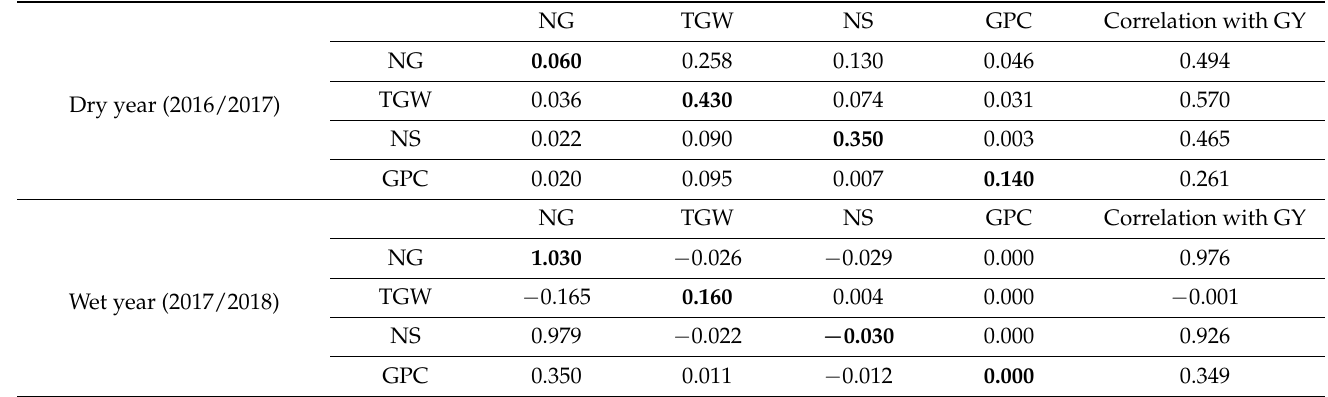
Figure 4. Relation between grain protein content (GPC %) and nitrogen agro-physiological efficiency (APE) in a dry year (2017); left [R 2 = 0.47 **, p -value < 0.01], and in a wet year (2018) right [R 2 = 0.16 ns ]. (ns: no significant, **: p < 0.01). Table 5. Path coefficient of the direct and indirect effects of the number of spikes · m − 2 (NS), number of grains · m − 2 (NG), thousand grain weight (TGW), and grain protein content (GPC) in the dry year and the wet